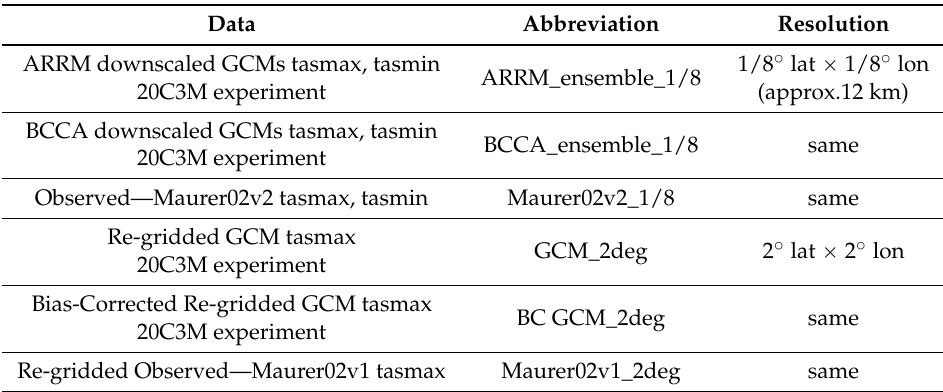
Table 2. List of data used to calculate the heat indices.